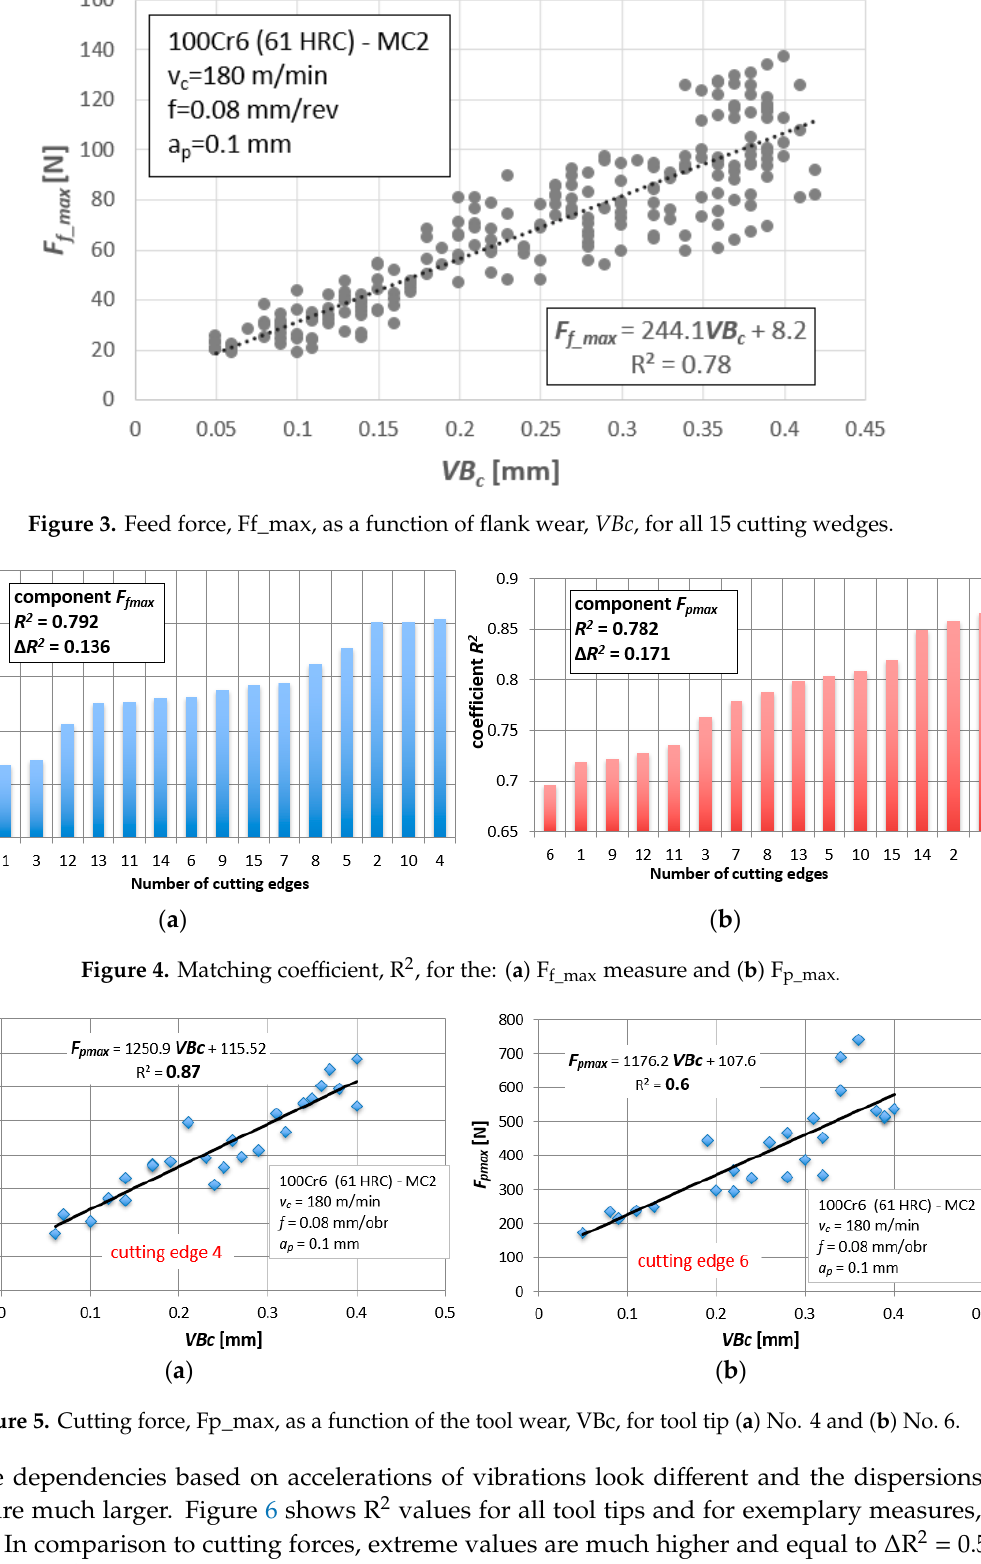
( b ) Figure 6. Matching coefficient R 2 for (a) the Af measure and (b) the Ap measure ( a ) ( b ) Figure 7. Acceleration of vibrations in feed direction, Af, as a function of the tool wear, VBc, for tool tips ( a ) No. 1 and ( b ) No. 4.